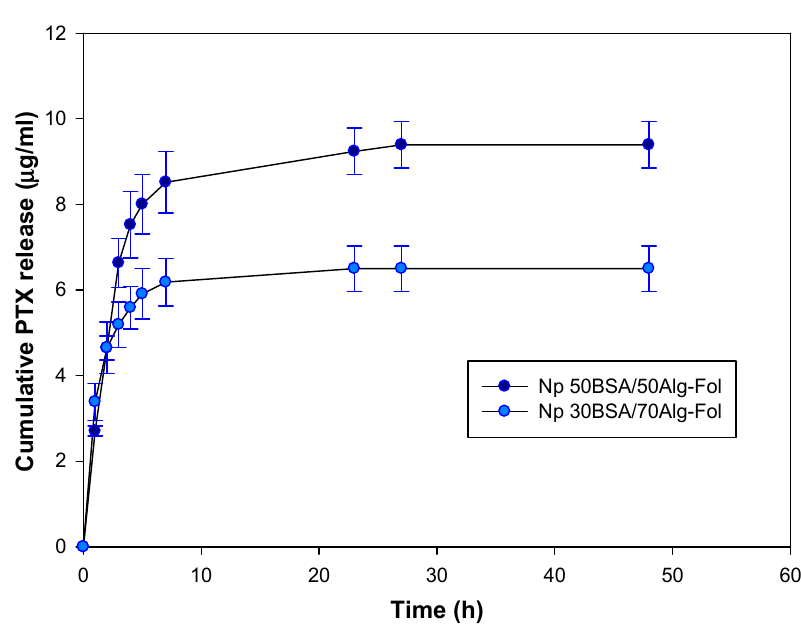
Figure 2. Cumulative release of PTX from BSA/ALG–Fol nanoparticles. Table 4. Release rates of PTX from 50BSA/50ALG–Fol and 30BSA/70ALG–Fol nanoparticles.